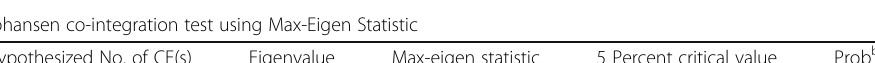
Table 3 Johansen co-integration test using Max-Eigen Statistic Johansen co-integration test using Max-Eigen Statistic Hypothesized No. of CE(s) Eigenvalue Max-eigen statistic 5 Percent critical value Prob b None a 0.505093 30.24556 0.0222 At most 1 0.357834 19.04508 At most 2 0.174253 8.233090 At most 3